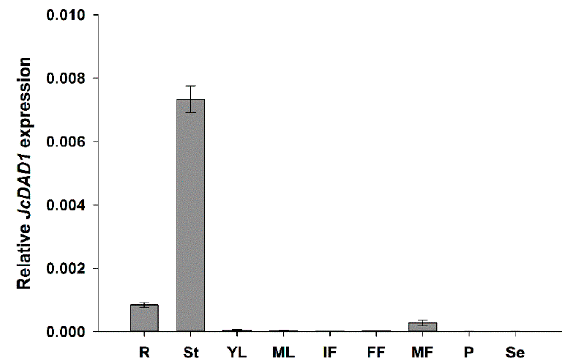
Figure 2. Tissue-specific expression analysis of JcDAD1 in different tissues of adult Jatropha plants. Three biological replicates and three technical replicates were prepared for qRT-PCR. JcActin was used as the internal reference. Error bars represent standard errors ( n = 3). FF, female flowers; IF, inflorescences; MF, male flowers; ML, mature leaves; P, pericarps; R, roots; Se, seeds; St, stems; YL, young leaves.